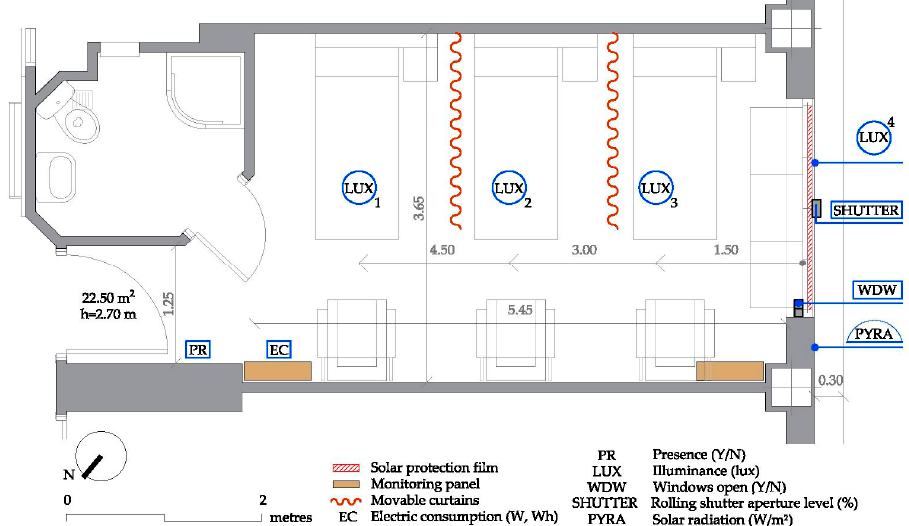
Figure 2. Floor plan of the hospital room monitored. Location of the sensors used. Source: Authors.